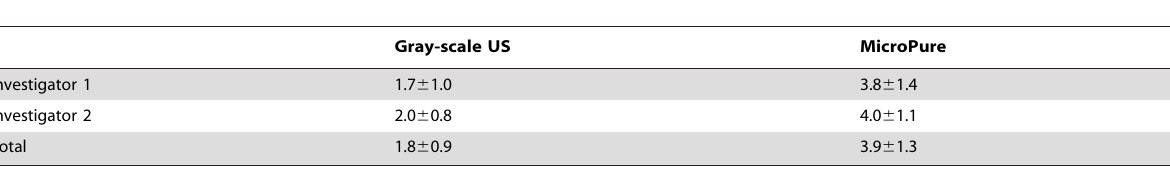
Table 2. Mean number of microcalcifications observed on the static